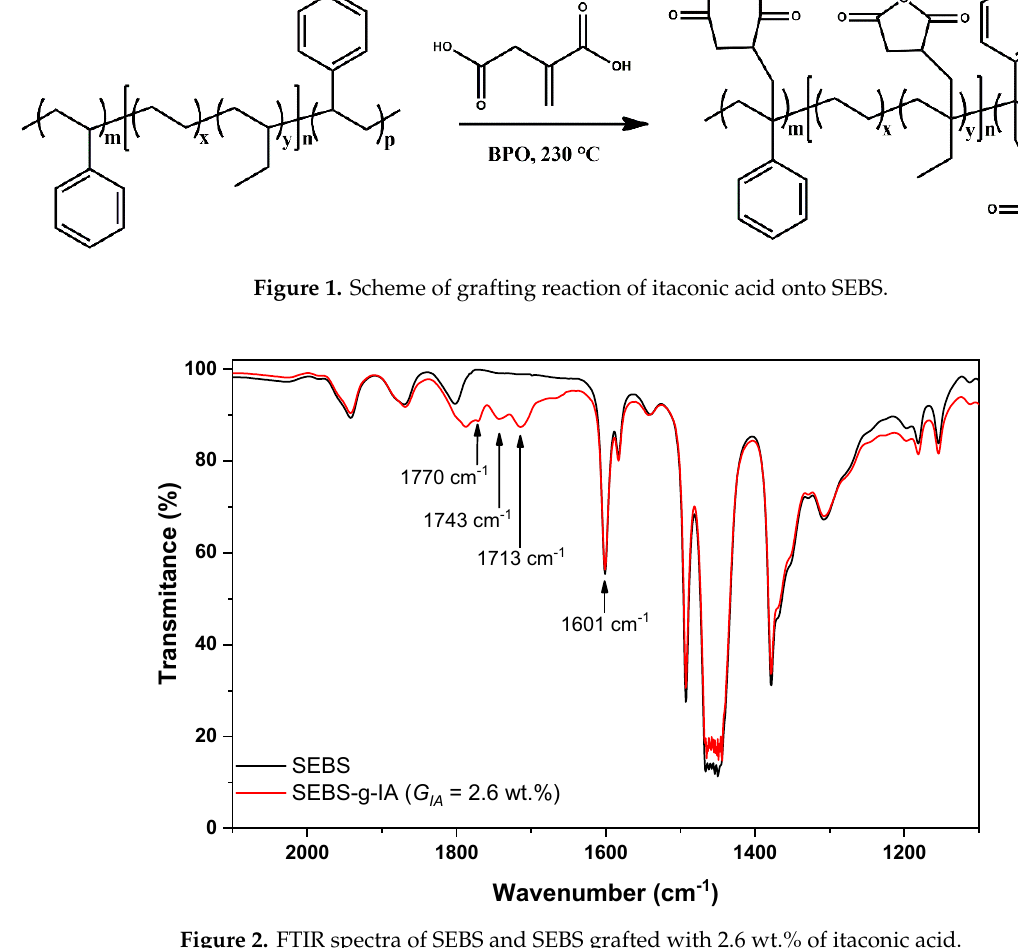
Figure 2. FTIR spectra of SEBS and SEBS grafted with 2.6 wt.% of itaconic acid.